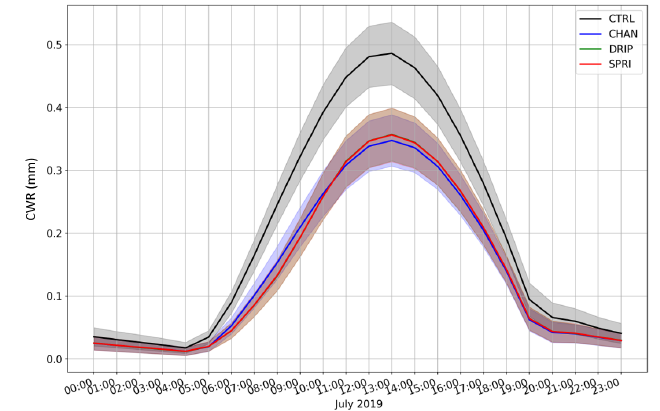
Figure 10. Crop water requirement (CWR): diurnal cycle for July